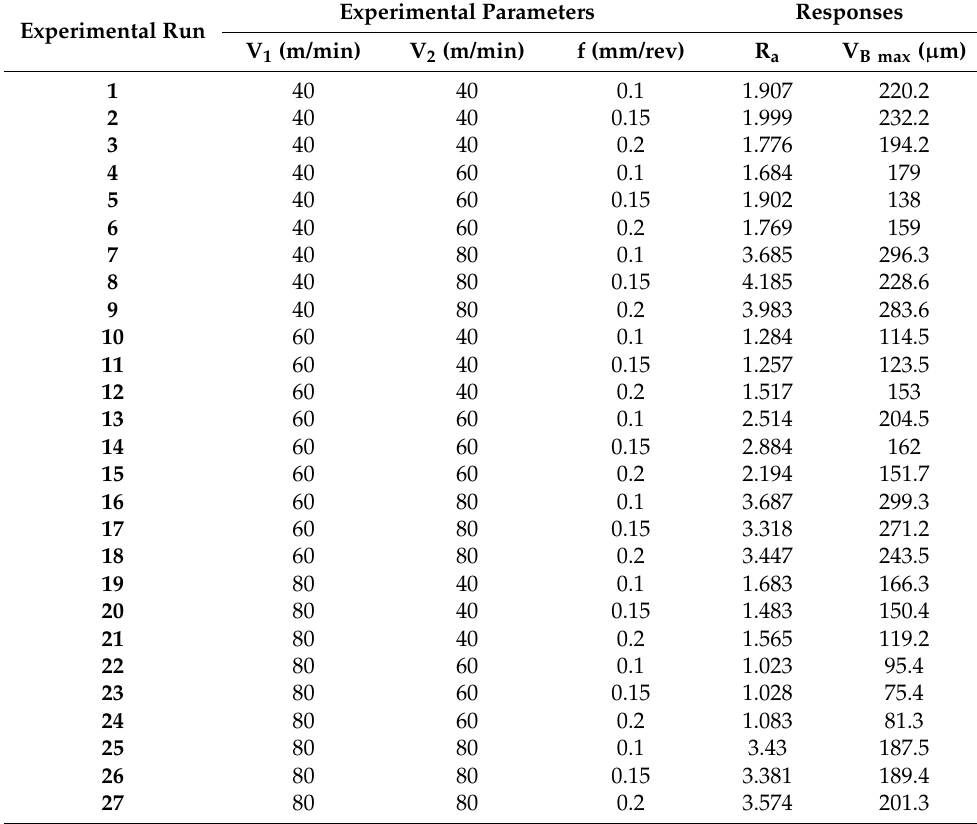
Table 4. Input cutting parameters and their responses. Experimental